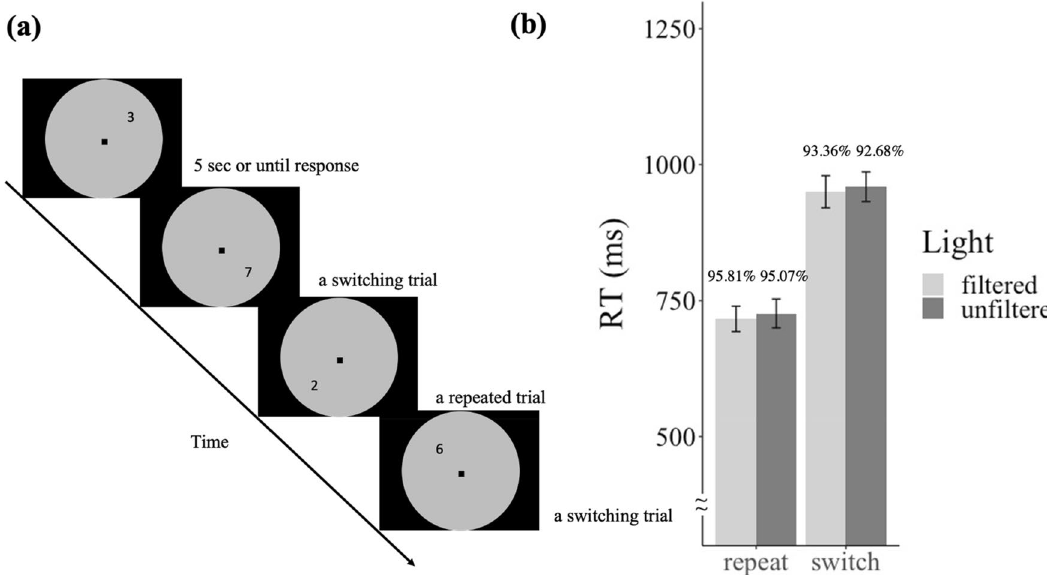
Figure 4. ( a ) The experimental design of Experiment 4. ( b ) Reaction time in repeated and switching trials in Experiment 4. Error bars represent one S.E.M. The number shown above each bar denotes the accuracy of each